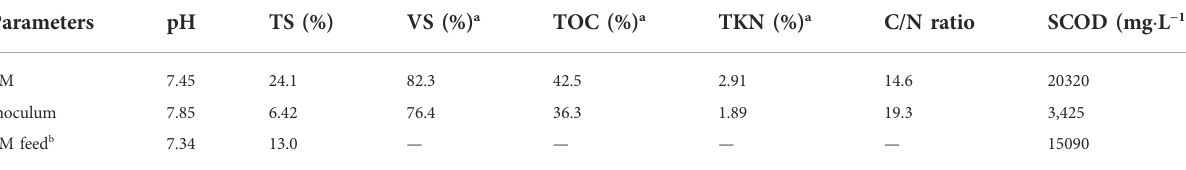
TABLE 1 Characteristics of PM and